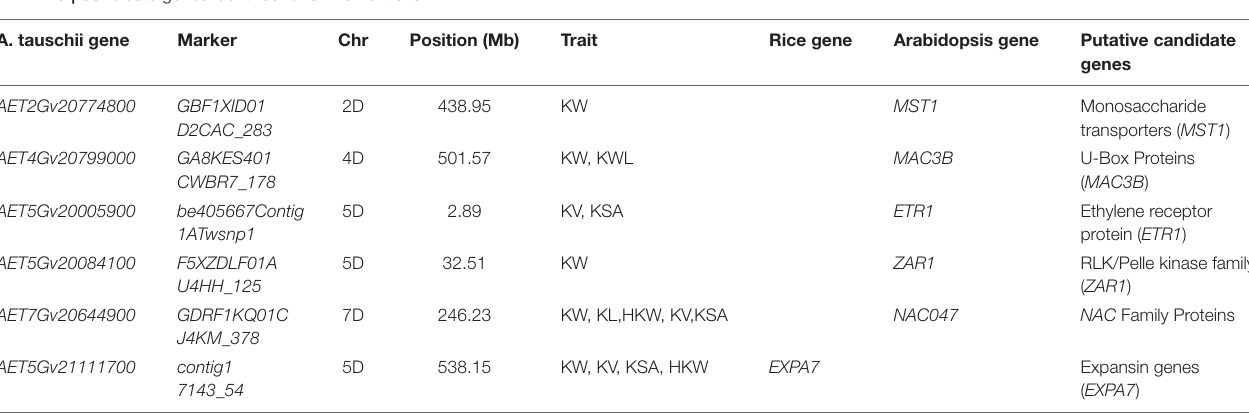
TABLE 5 | Candidate genes identified for six kernel